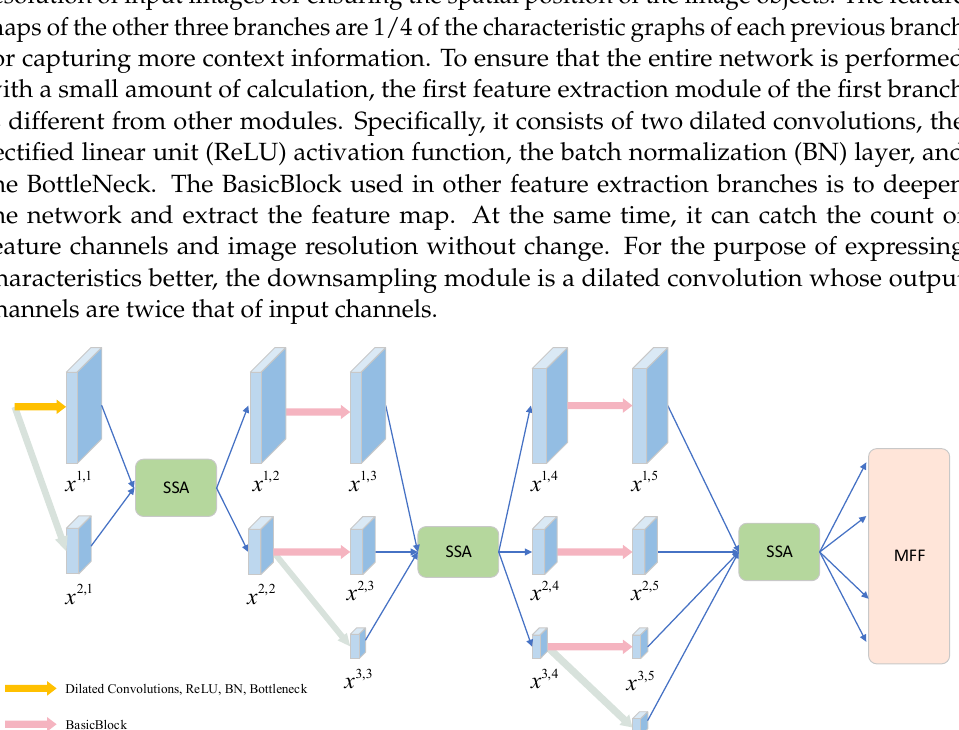
Figure 1. The flow chart of the SFnet-DA.